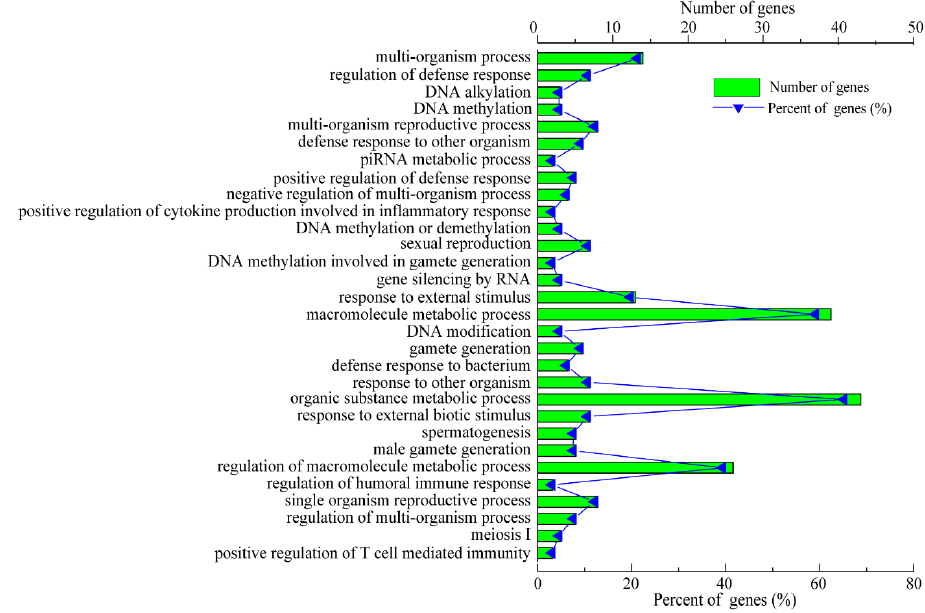
Figure 6. GO term analysis of the biological functions of the identified lncRNA target genes.